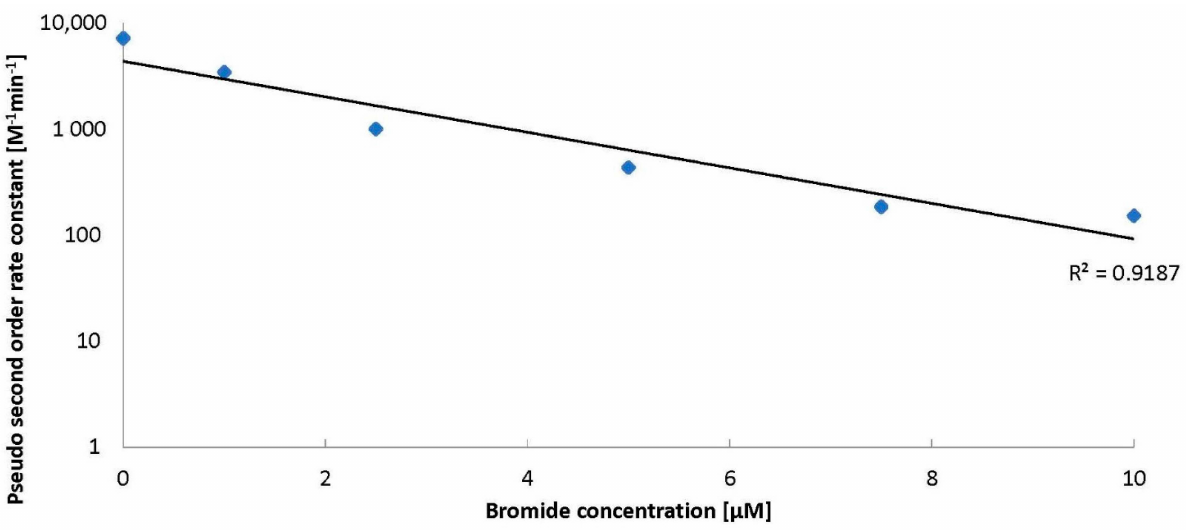
Figure 2. The ozone decomposition kinetics in the presence of BA (24 µ M) and bromides (0–10 µ M), pH =